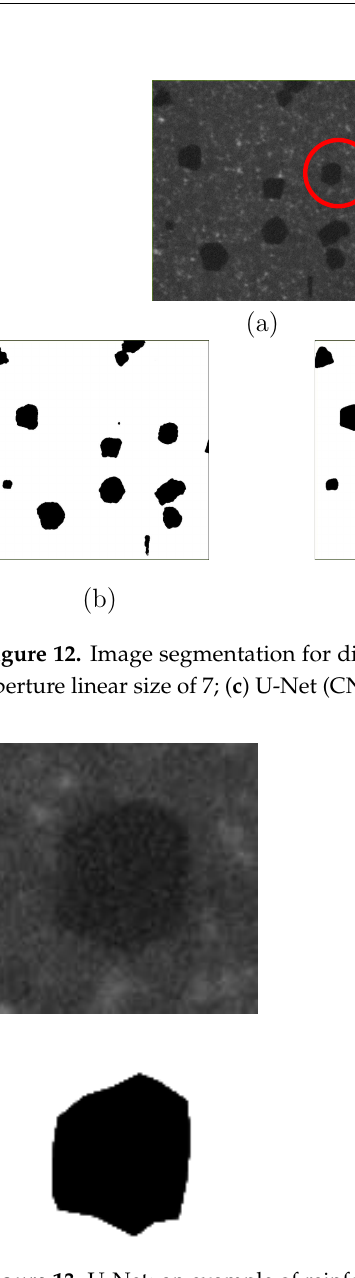
Figure 13. U-Net: an example of reinforcemen learning to capture the feature details of the diamond marked with a red circle in Figure Fig. 13: U-Net: an example